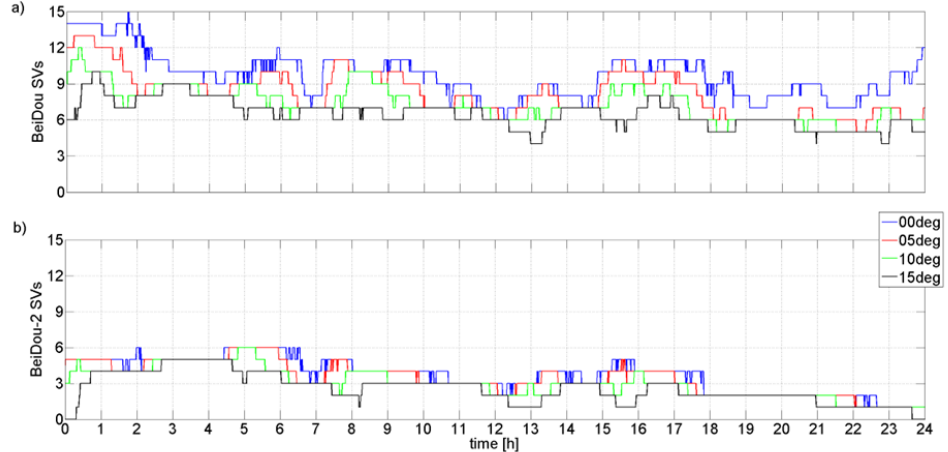
Figure 6. BeiDou SVs visibility on AUBG station (day 1 in the 2021 year): ( a ) all available BeiDou Figure 6 . BeiDou SVs visibility on AUBG station (day 1 in the 2021 year): a ) all available BeiDou SVs, ( b ) BeiDou-2 SVs. SVs, b ) BeiDou-2 SVs.